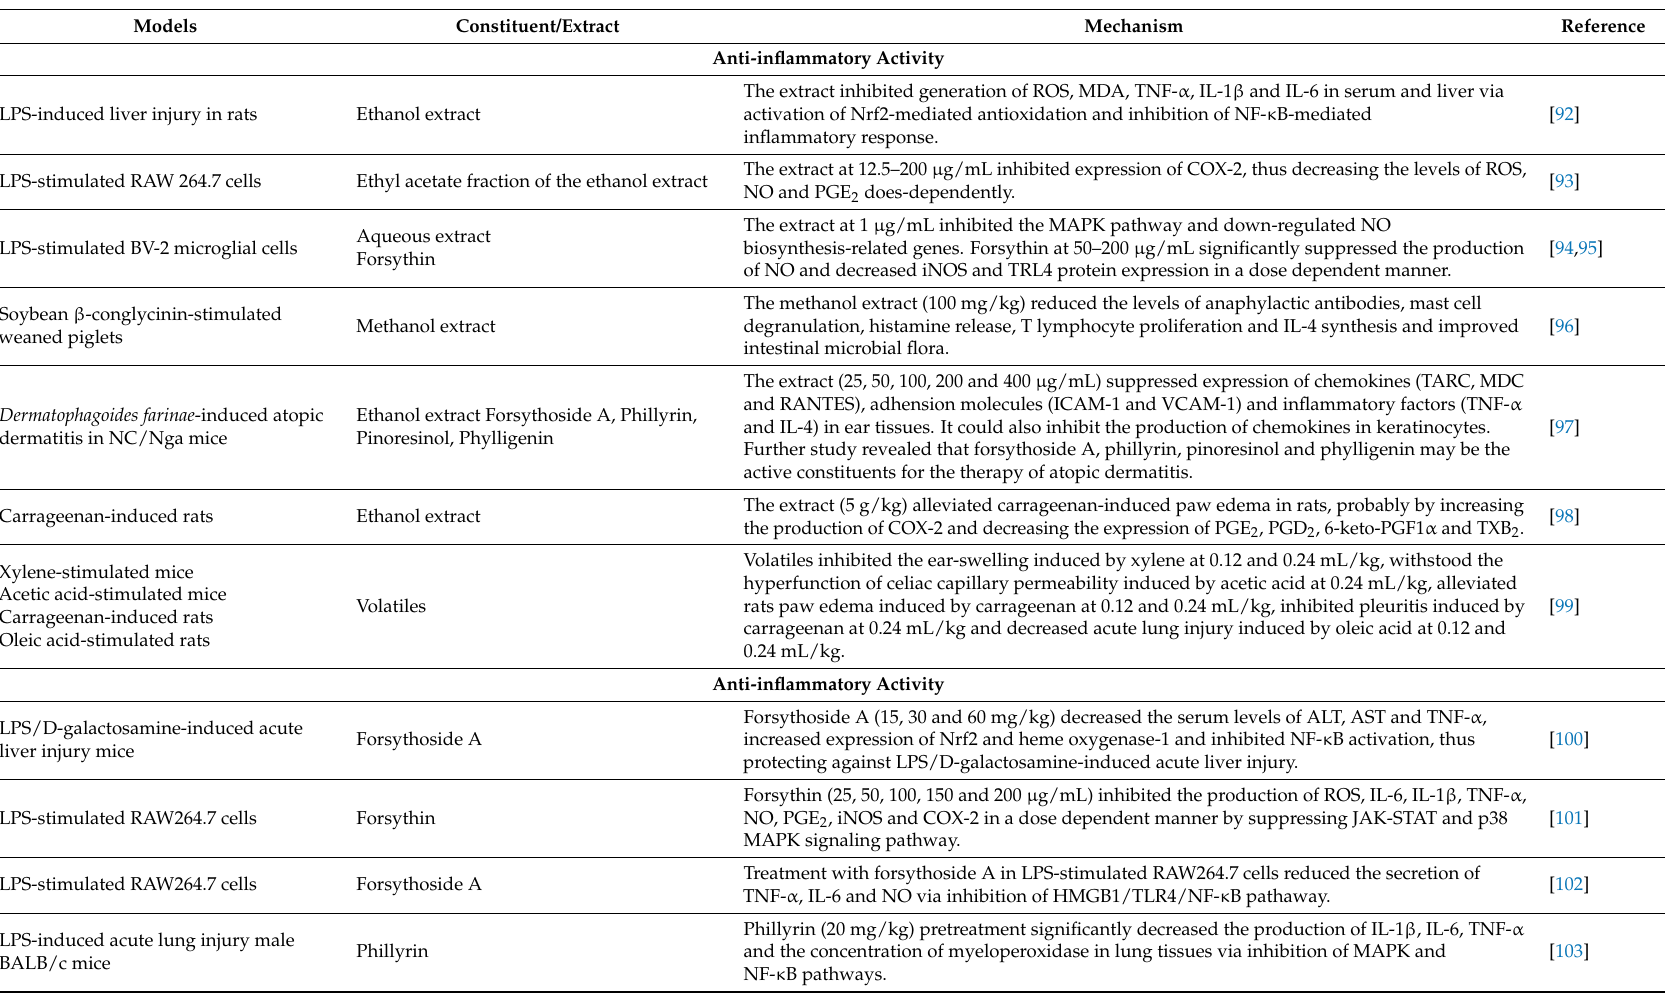
Table 3. Pharmacological effects of Forsythiae